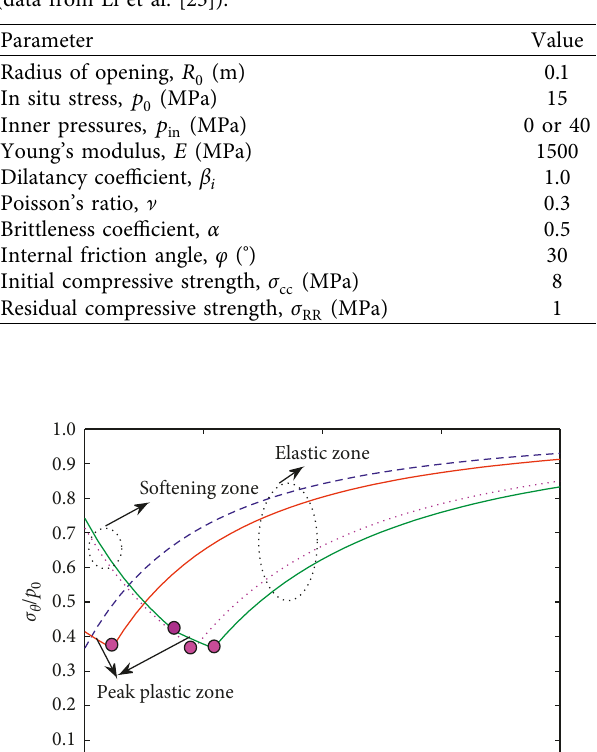
Table 3: The maximum critical inner hydraulic pressure p